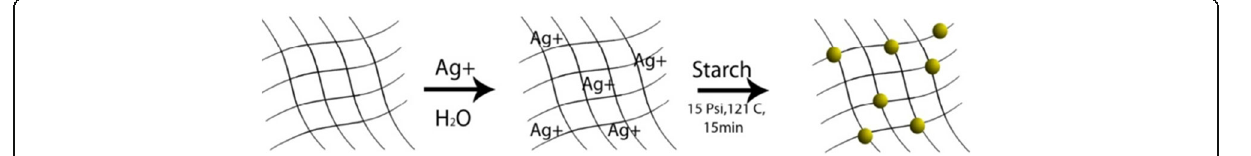
Fig. 14 Schematic diagram of impregnation of silver nanoparticles on cotton fabric [86]